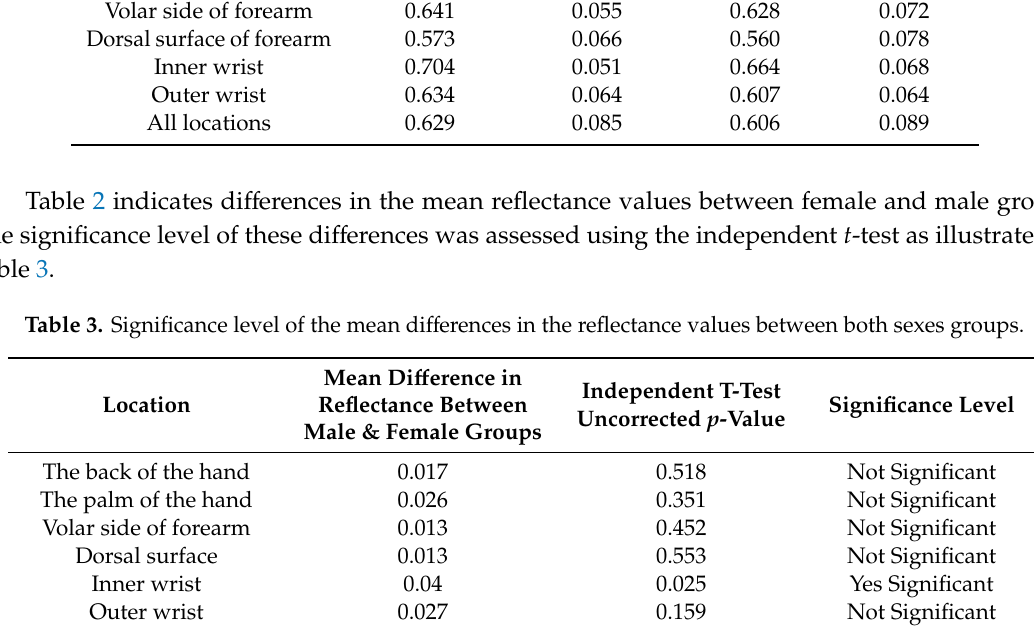
Table 2. A comparison in the mean reflectance values of the skin for males and females over all locations. Location